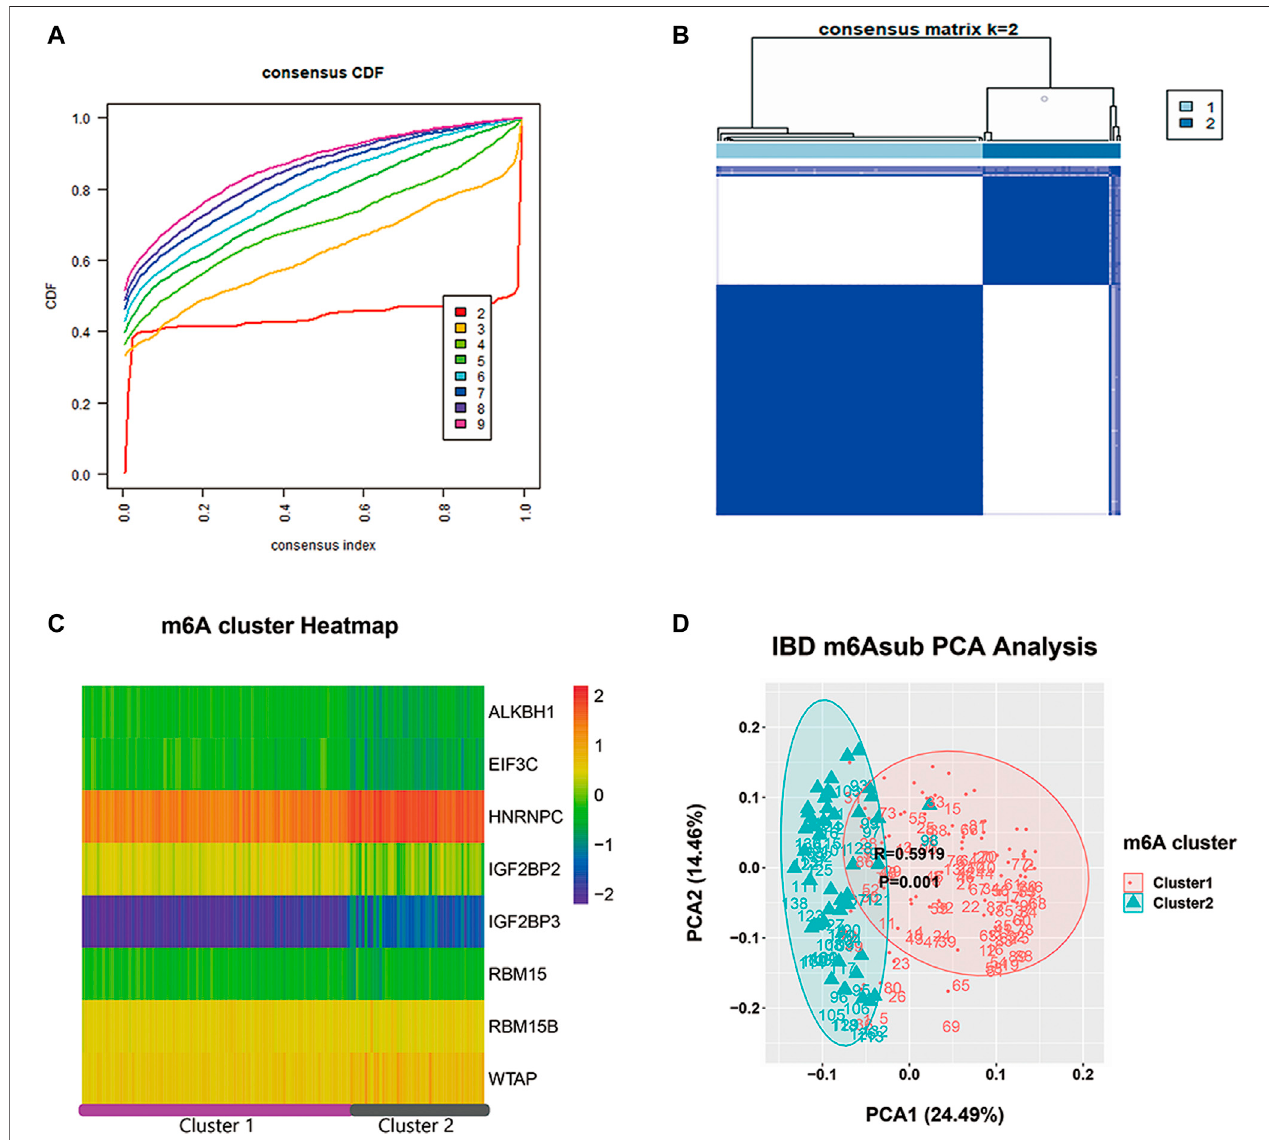
FIGURE 3 | The consensus clustering analysis of m6A regulators in IBDMDB cohort. (A) is the consensus CDF diagram which show a good clustering is obtained when k (cid:1) 2. (B) isthe different clusters after consensus clustering by k (cid:1) 2, (C) isthe heatmap of m6A reader, writer and eraser expression in different clusters. (D) is the PCA analysis that shows well discrimination between two